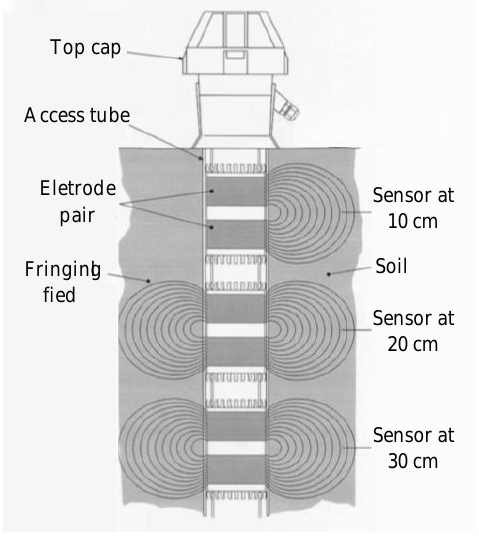
Figure 3. Schematic of the dielectric probe equipped with electromagnetic sensors.